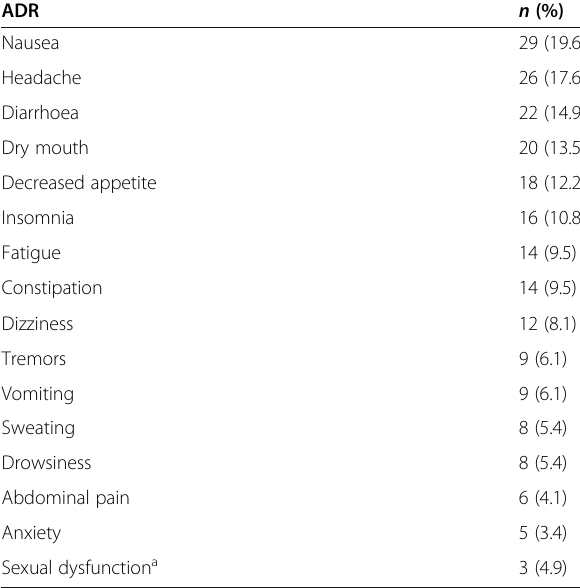
Table 3 Summary of adverse drug reactions (ADRs) seen in ≥ 3% of patients ( N =